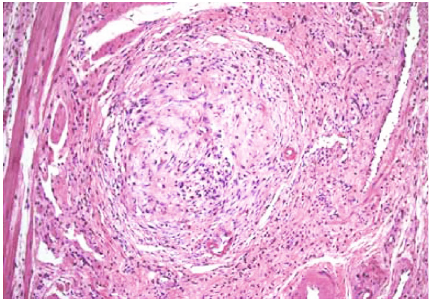
Figure 1: CT angiogram of the abdomen showed active bleeding in the jejunum (arrow).